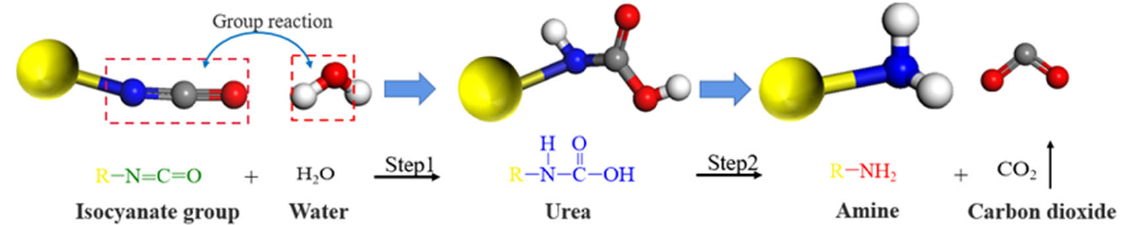
Figure 6. Reaction process of isocyanate and water.